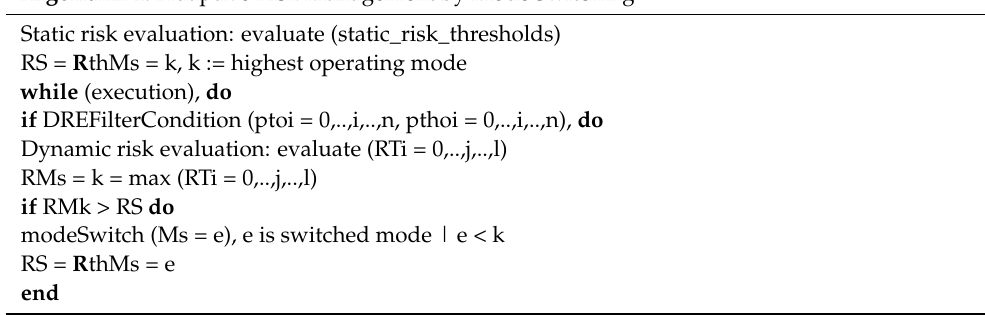
Algorithm 1: Adaptive Risk Management by Mode